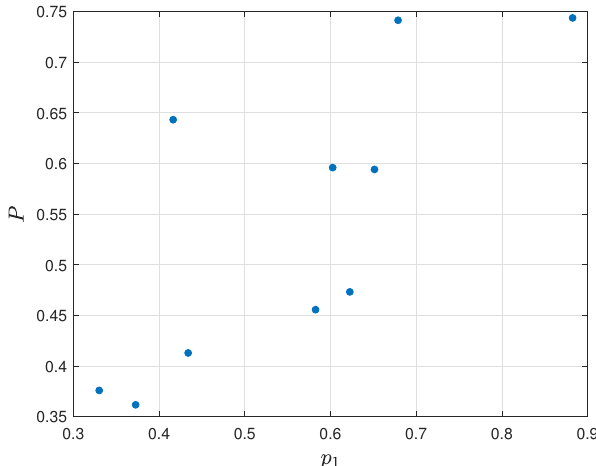
Figure 19. The relation diagram of the Effectiveness per round assessment ( P 1 ) for final assessment P .